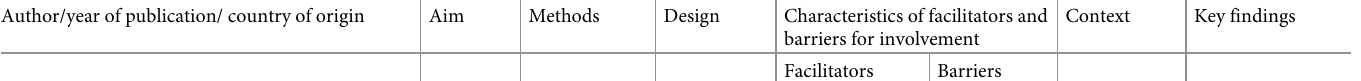
Table 3. Data presentation